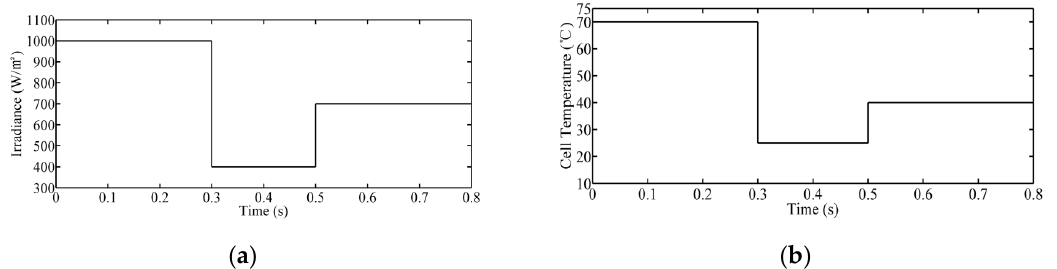
Figure 12. Fast variations: ( a ) solar irradiance and ( b ) solar cell temperature for PV array 1.